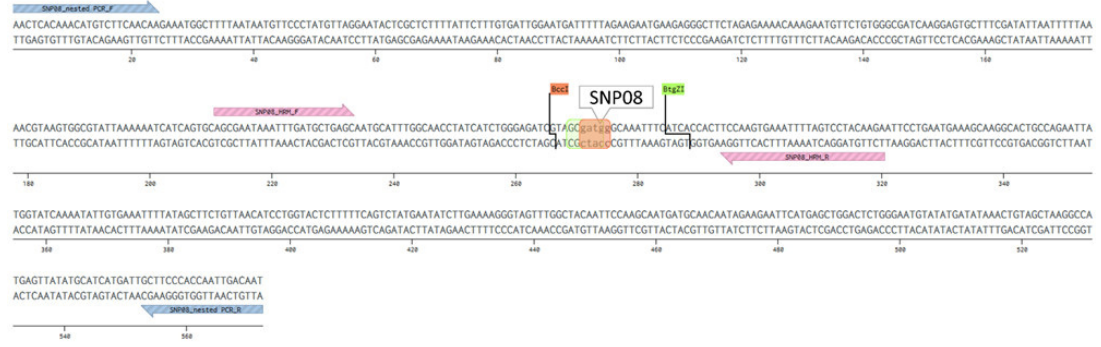
Figure 7. Amplicon with related primers; in blue, the first cycle of nested PCR, and fuchsia, the second cycle, respectively, carried out in a standard and HRM thermocycler. The BccI and BtgZI binding and cutting sites, respectively, in dark pink and light green.